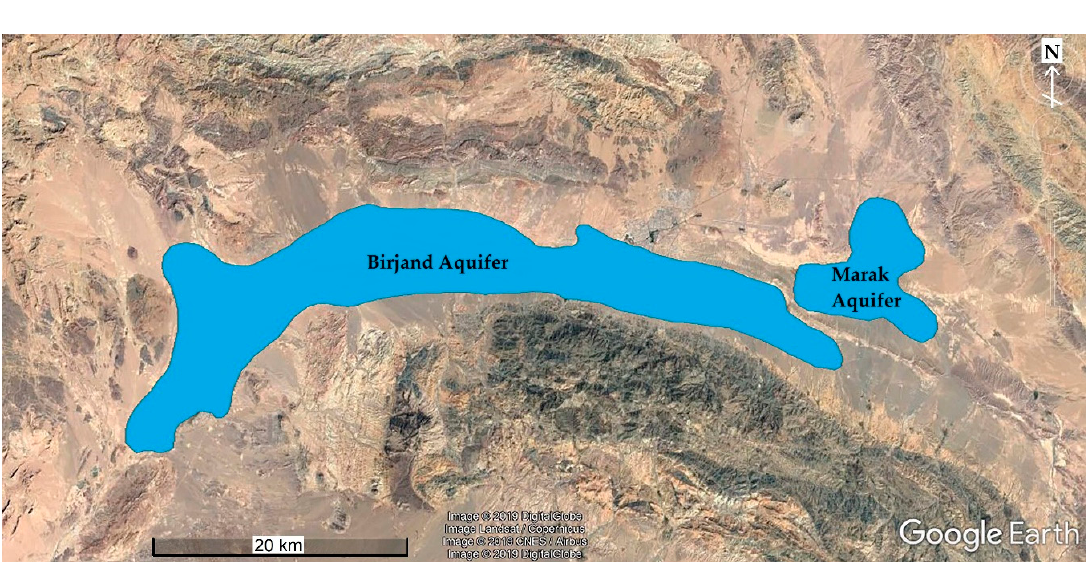
Figure 6. The study area and the exact location of Birjand and Marak aquifers.